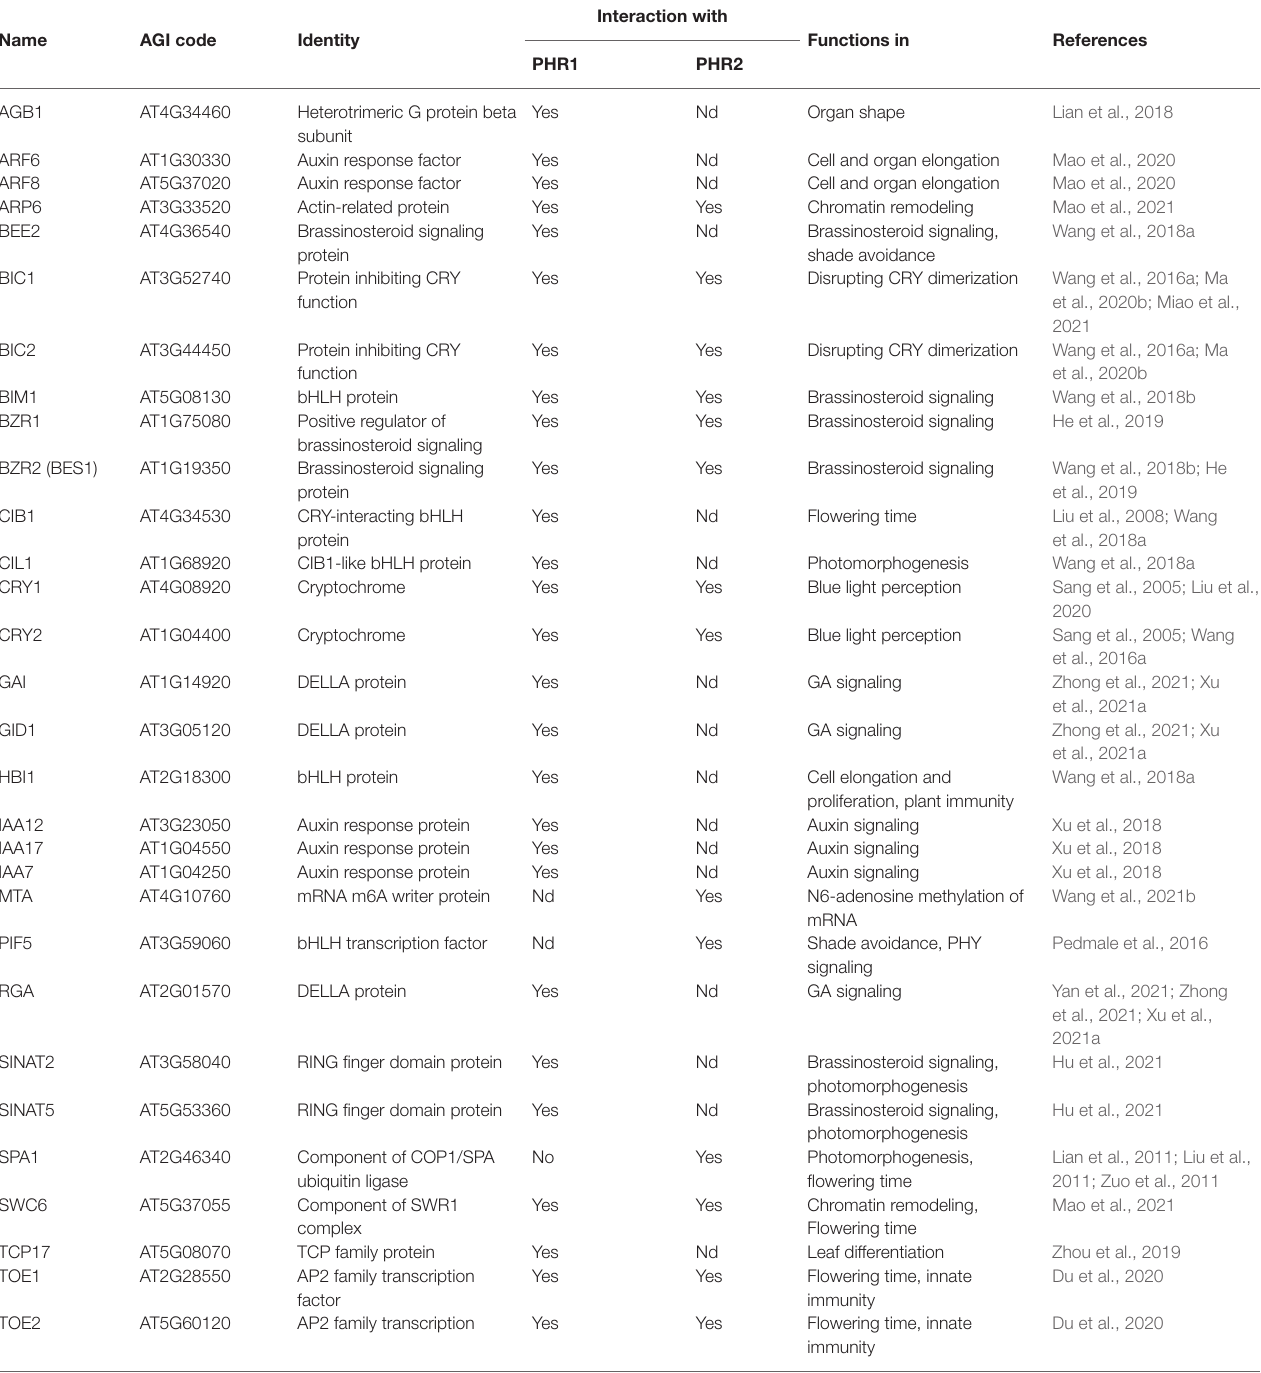
TABLE 1 | Proteins that interact with the N-terminal domains of Arabidopsis CRYs (PHR1 and